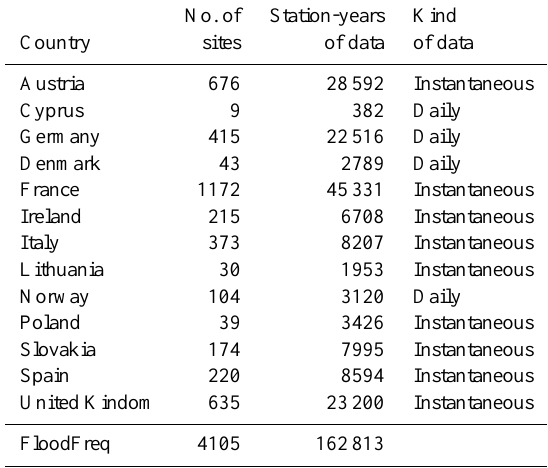
Table 1. FloodFreq streamflow database: number of sites and station-years of data for the national annual maxima